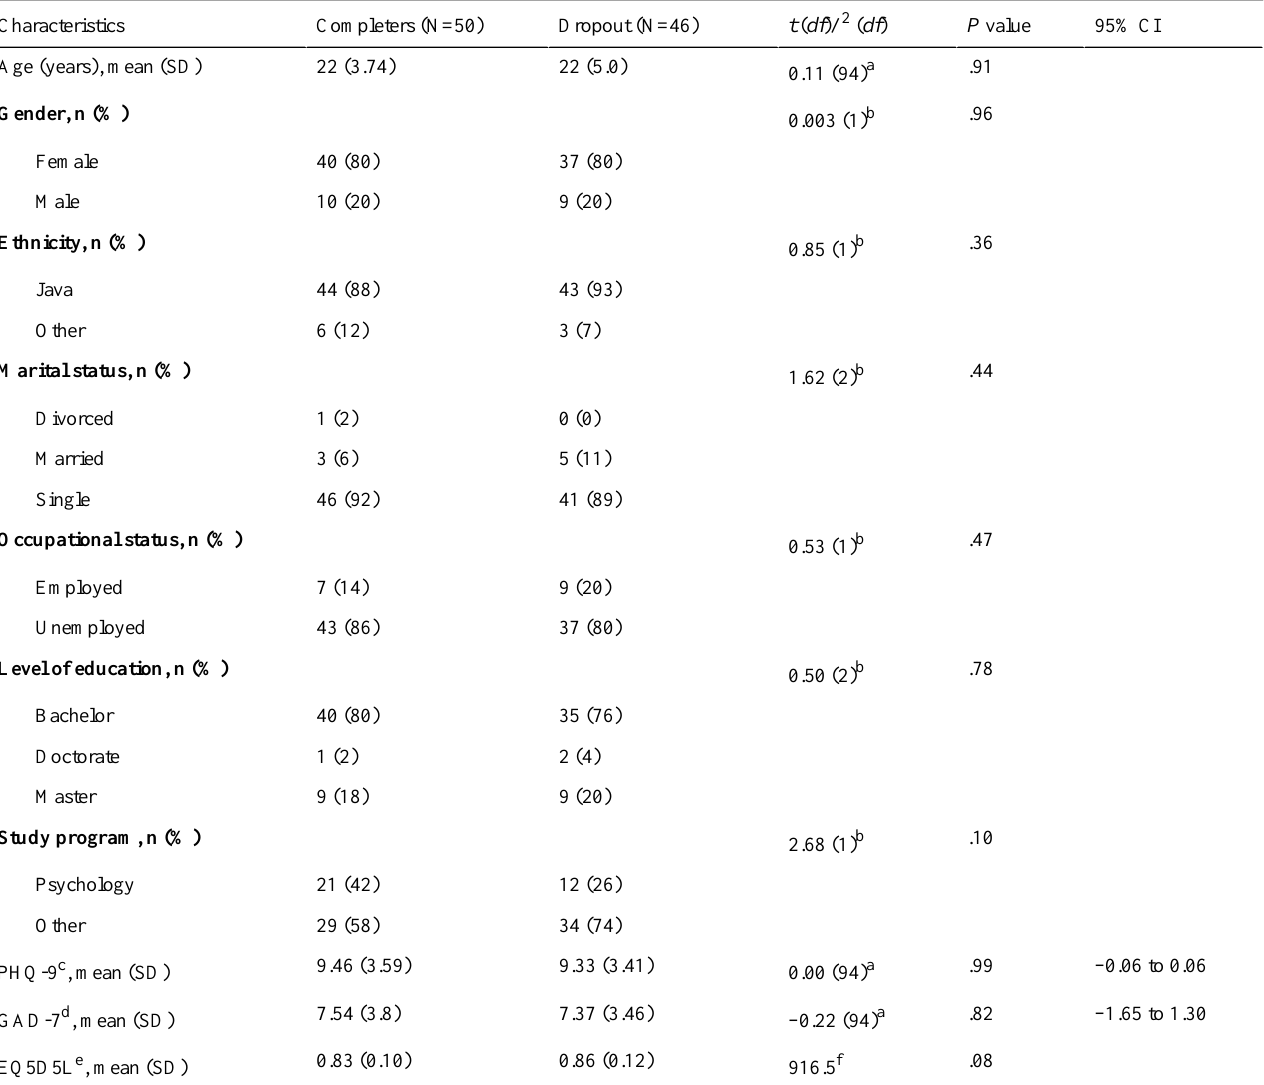
Table 3. Participants’characteristics and baseline differences between completers and